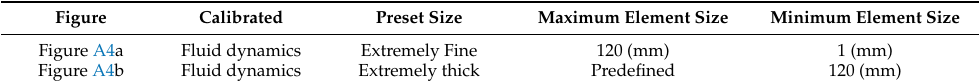
Fluid dynamics Extremely Fine